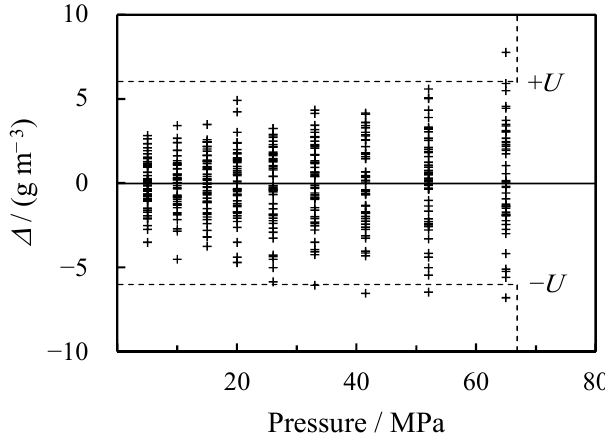
Figure 8. Residuals (cid:49) (measured minus predicted values) yielded (p − p 0 ) . U – uncertainty in the density– by the fit of (cid:49)(cid:49)ρ SW 0 salinity relation for high